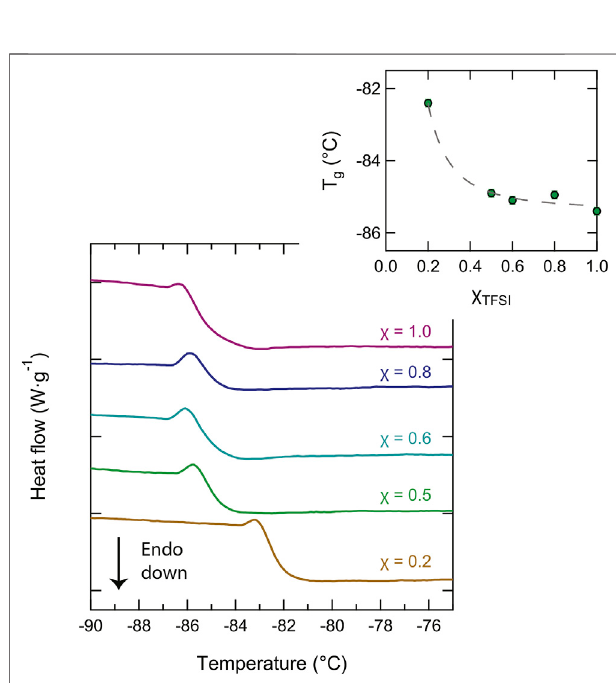
FIGURE 5 | Close-up of the DSC traces showing the low-temperature range where the glass transition temperature, T g , appears. The dependence of T g on composition is shown in the inset plot.